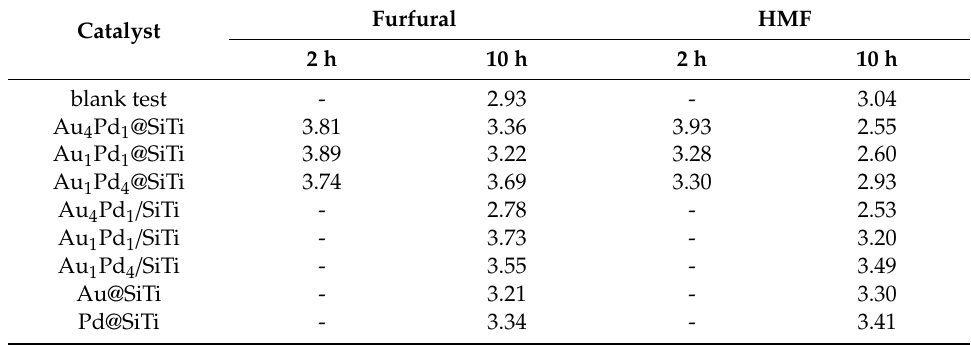
Table 5. Final pH values of furfural and HMF oxidation reactions using embedded Au x Pd y @ SiTi and supported Au x Pd y / SiTi